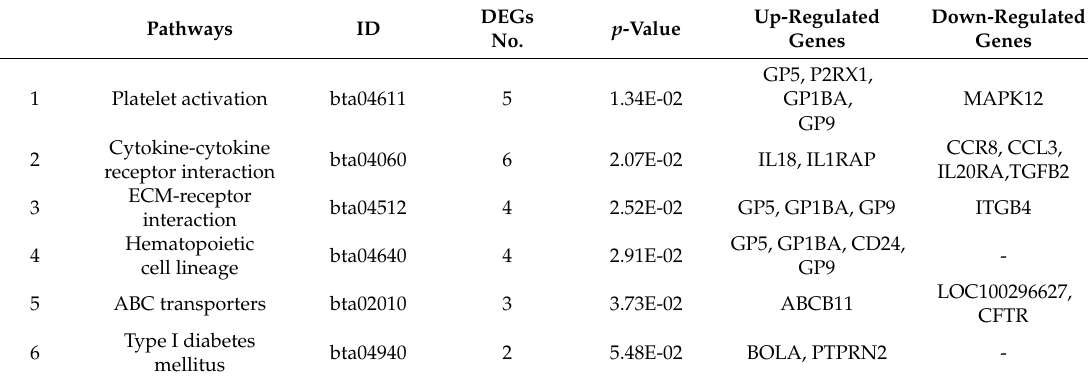
Table 2. List of significantly enriched Kyoto Encyclopedia of Genes and Genomes (KEGG) pathways associated with immune